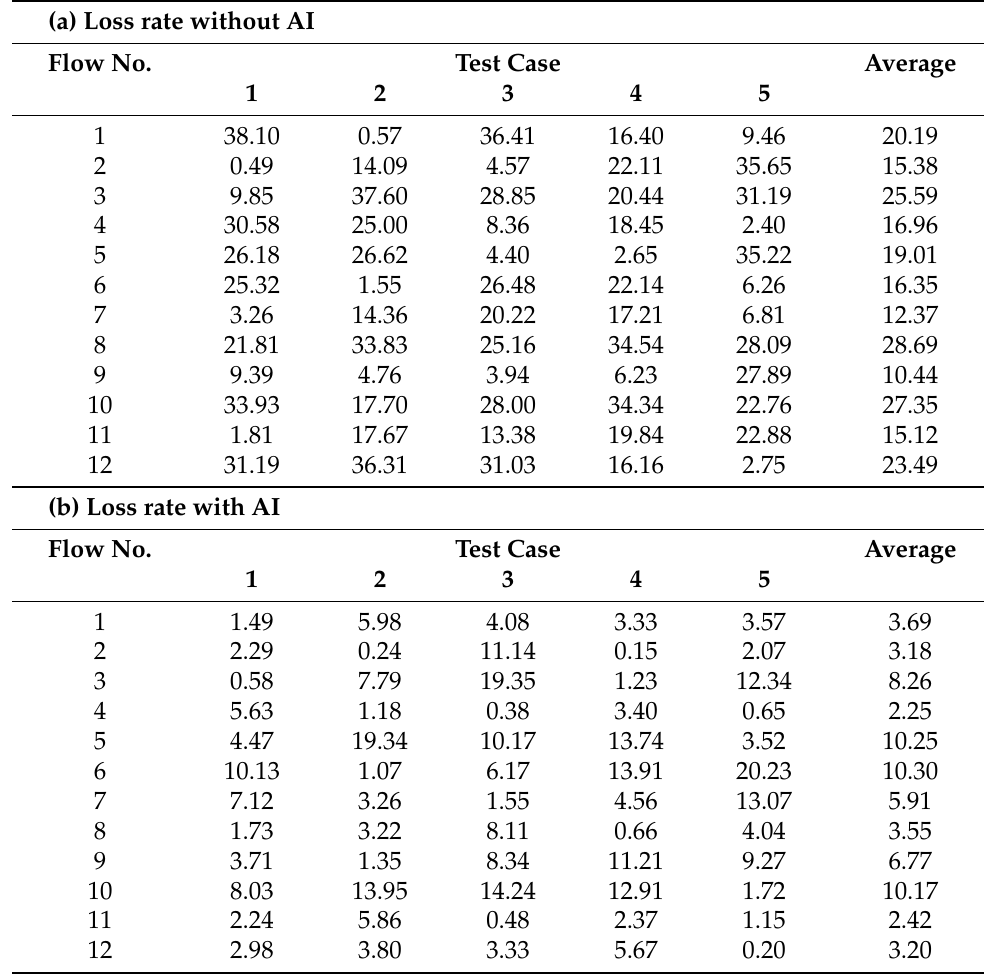
Table 2. Comparison of flows’ loses for different test case. (a) Loss rate without AI Flow No.